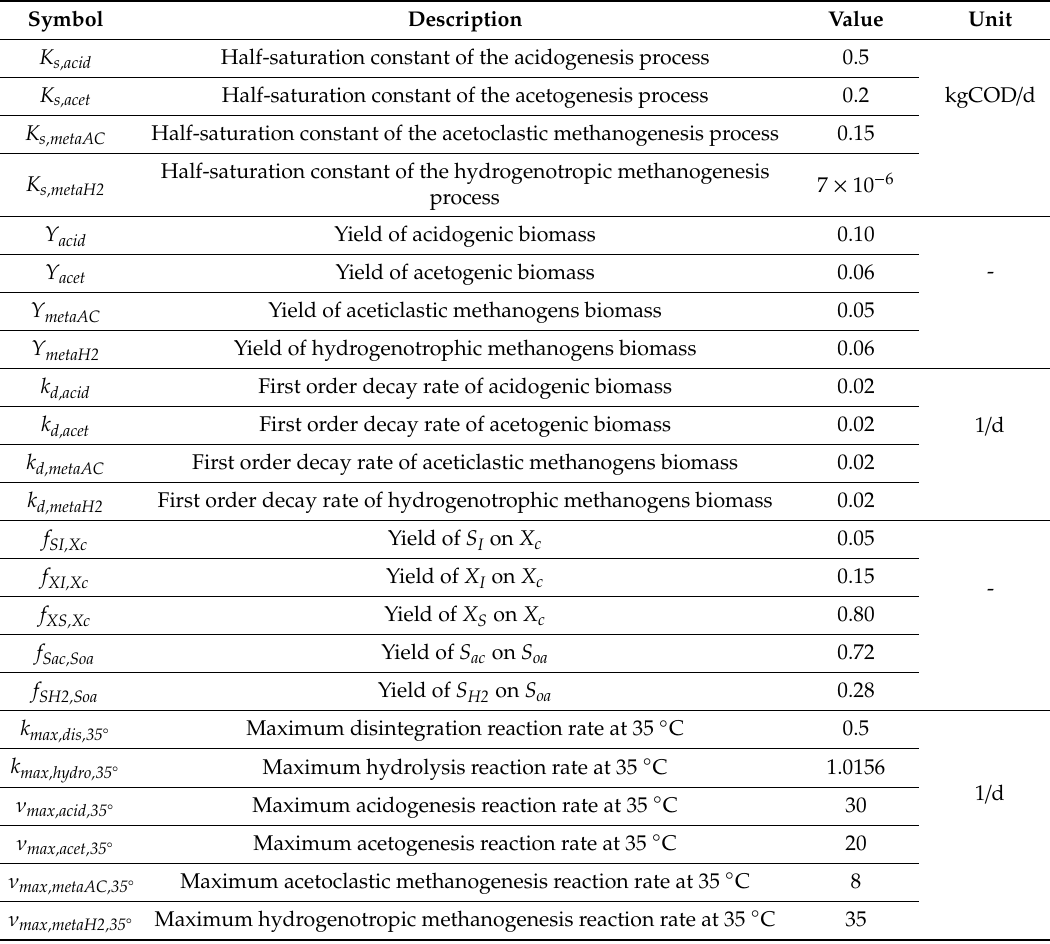
Table 4. Stoichiometric coe ffi cients, kinetic parameters and rates.